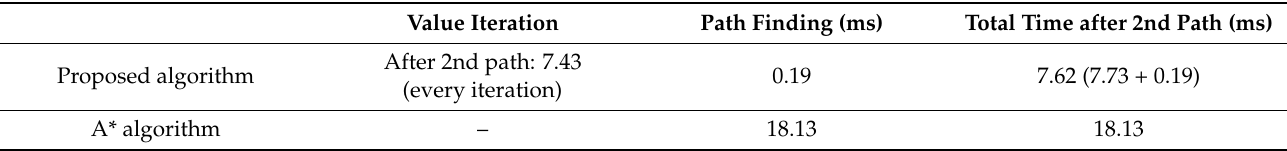
Table 5. The environment contains 50 moving